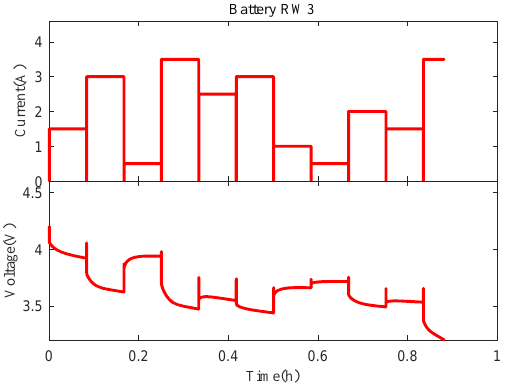
Figure 4. Example of the voltage curve when the load is random during discharge